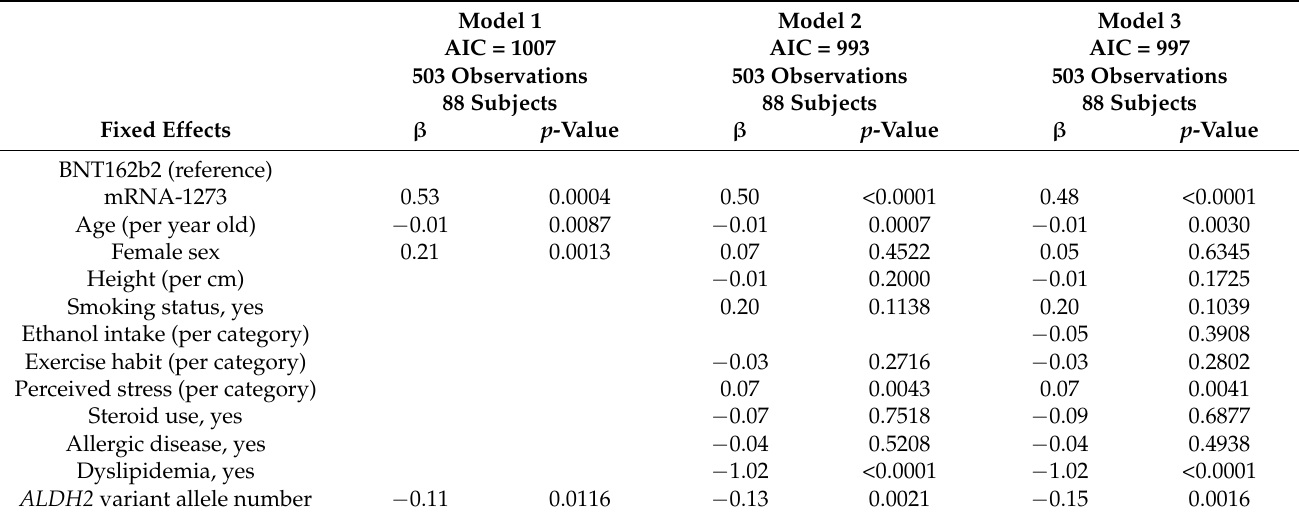
Table 3. Estimated fixed effects of baseline characteristics on log-transformed anti-S1 IgG, BAU/mL.